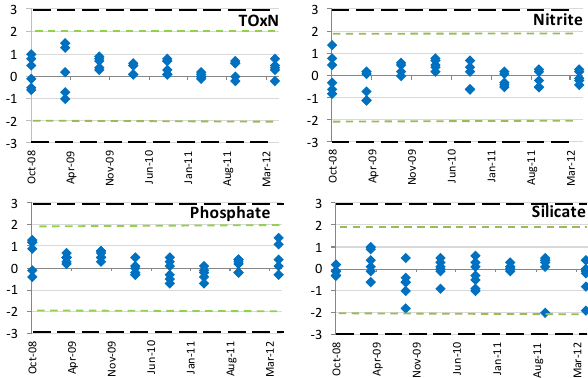
Figure 4. z scores of 8 QUASIMEME rounds of nutrients in the Figure 4 z-scores of 8 QUASIMEME rounds of nutrients in the marine environment between marine environment between October 2008 and May 2012, where October 2008 and May 2012, where the green dashed lines indicate a z-score of 2. The dashed the green dashed lines indicate a z score of 2. The dashed black black line at a z score of ±3 designates unsatisfactory performance. Most of the Quasimeme samples were in the range of oceanic values measured in the Rockall Trough. line at a z score of ± 3 designates unsatisfactory performance. Most of the QUASIMEME samples were in the range of oceanic values measured in the Rockall